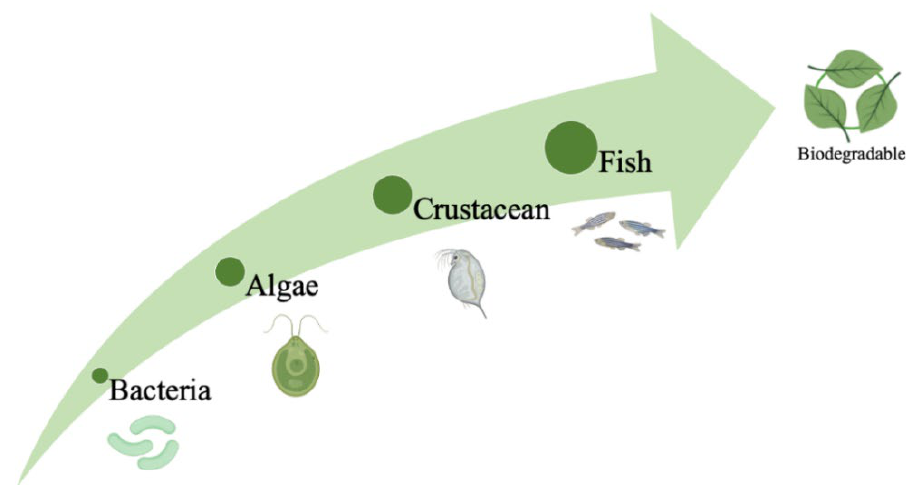
Figure 4. Biomodels used in the ecotoxicity evaluation of DESs, and the relationship with the trophic chain.